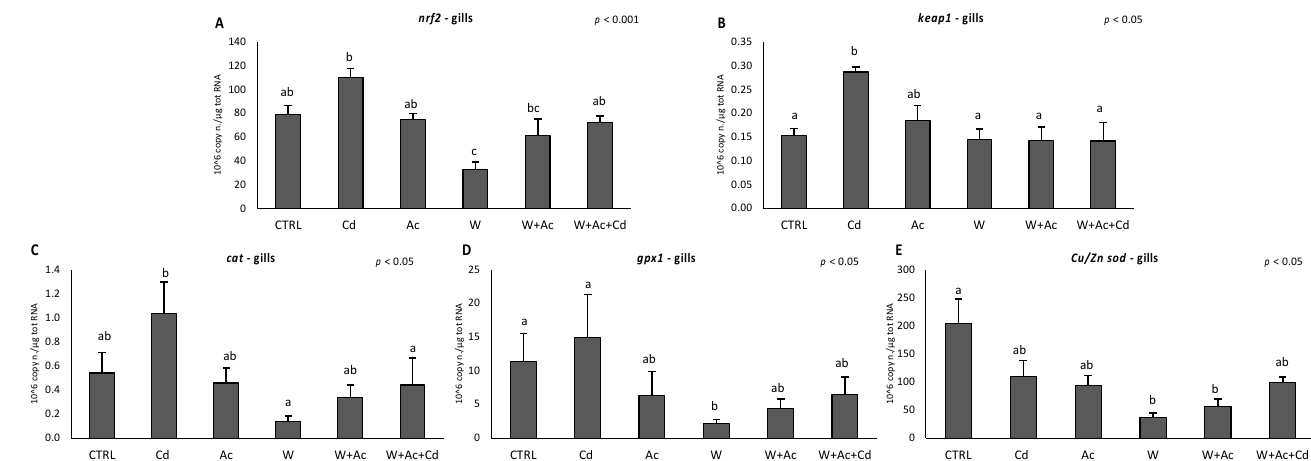
Figure 2. Transcriptional responses of antioxidant regulation system ( A , nrf2 ; B , keap1 ) and antioxidant enzymes ( C , cat ; D , gpx1 ; E , Cu/Zn-sod ) in gills of T. bernacchii . Different letters highlight significant differences between groups of means. Data are expressed as mean ± standard deviations, n = 5.